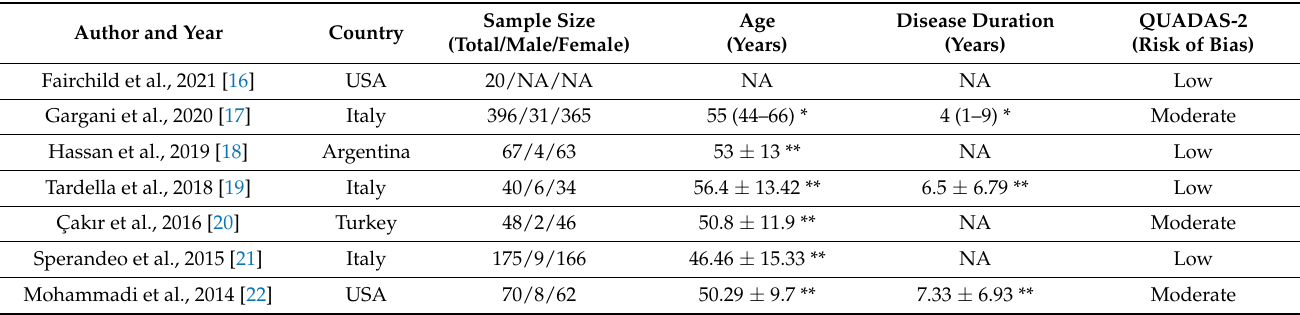
Table 1. Basic characteristics of included